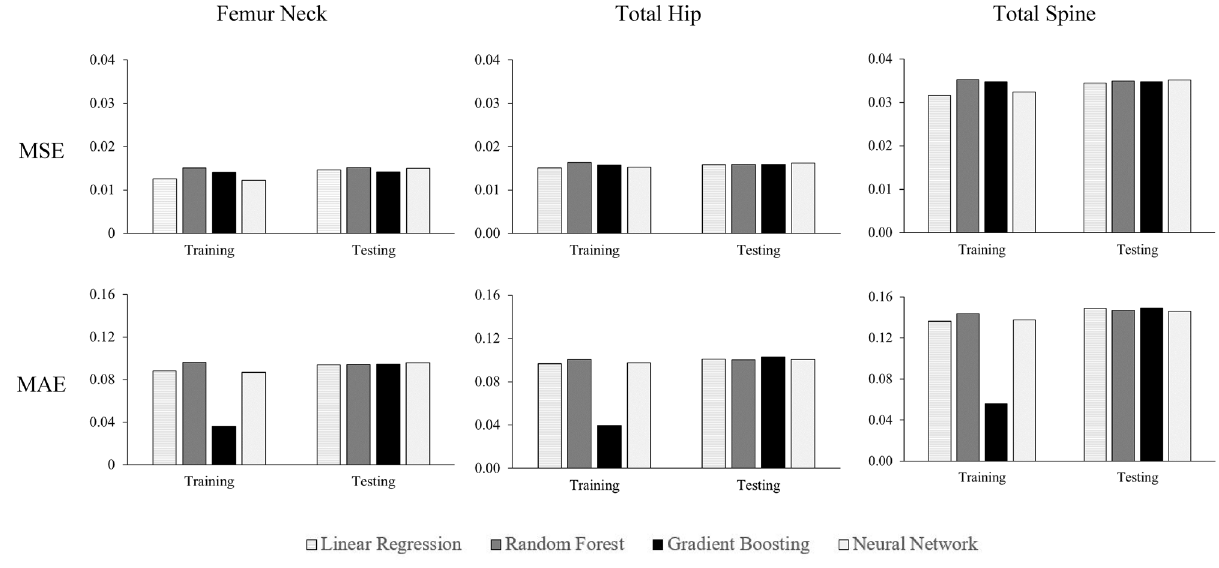
Figure 1. Mean square error (MSE) and mean absolute error (MAE) of different models in predicting various BMD in training (n = 4104) and testing (n = 1026); GRS and phenotypic covariates were used as predictors.